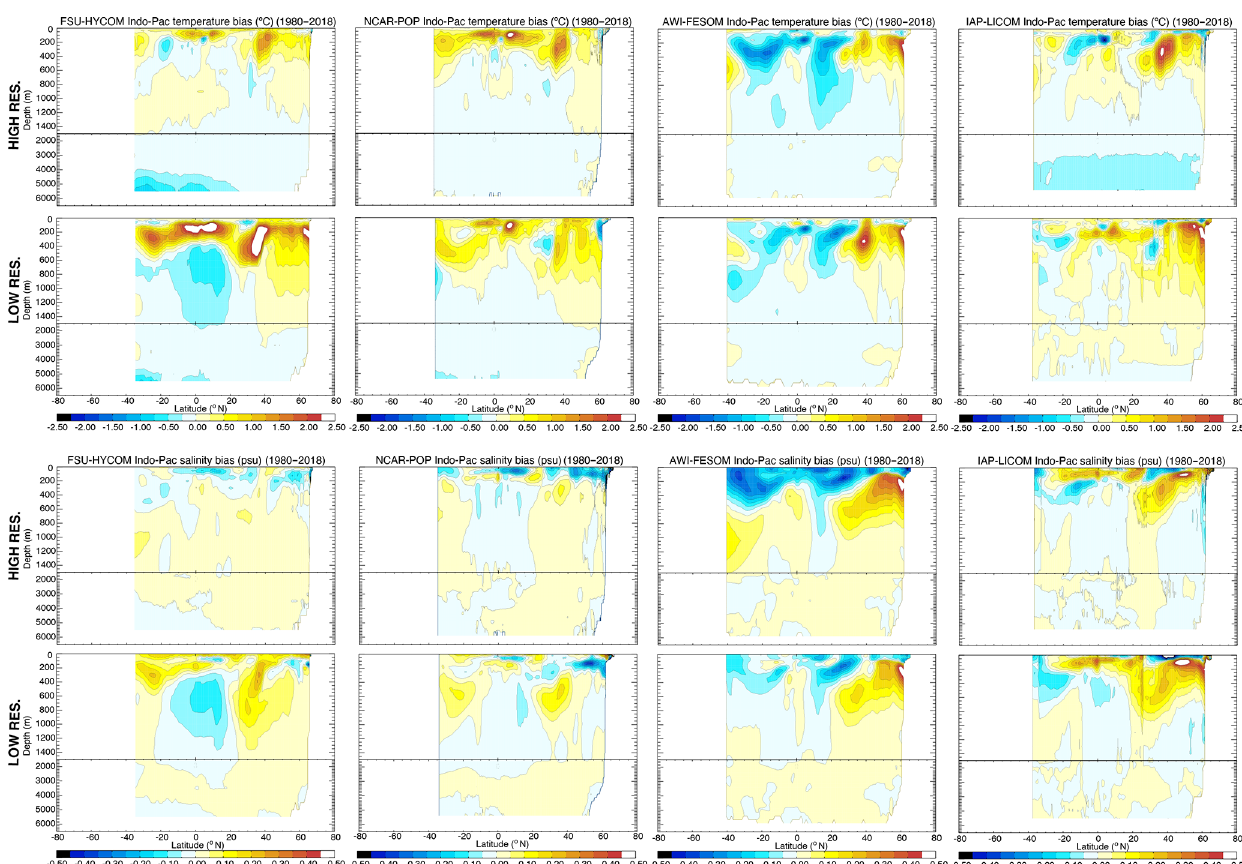
Figure 13. Indo-Pacific zonal temperature ( ◦ C) and salinity (psu) difference with the climatology used to initialize the